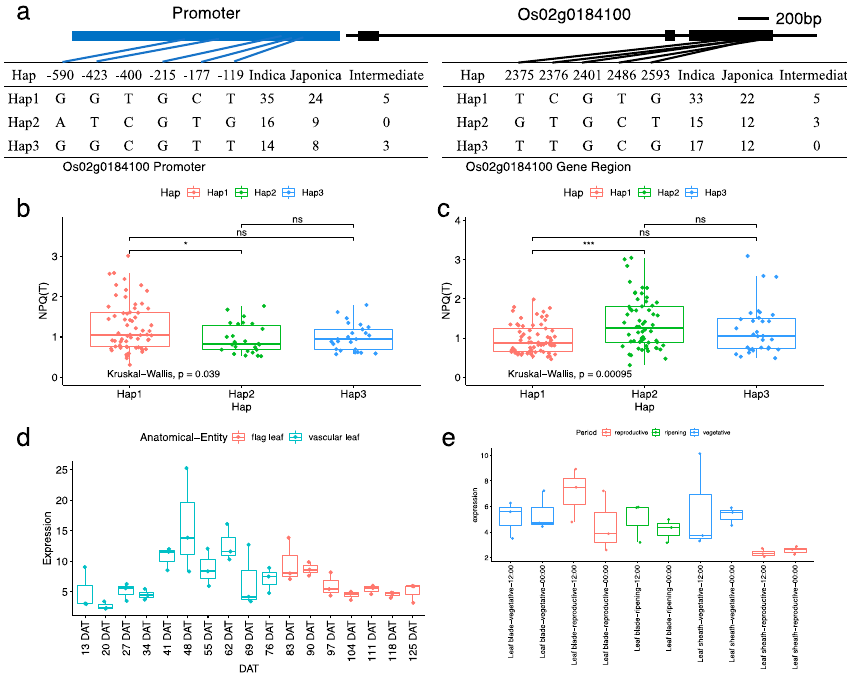
Figure 4. Candidate genes for NPQ(T) underlying the associated loci on chromosome 02. ( a ) Haplo- type analysis of Os02g0184100 . ( b , c ) Boxplots for NPQ(T) based on the genotypes of promoter ( b ) and gene region ( c ) of Os02g0184100 . ( d ) Expression pattern of Os02g0184100 in the vascular leaf and flag leaves of rice at different growth stages. ( e ) Diurnal expression pattern of Os02g0184100 in the flag leaves.